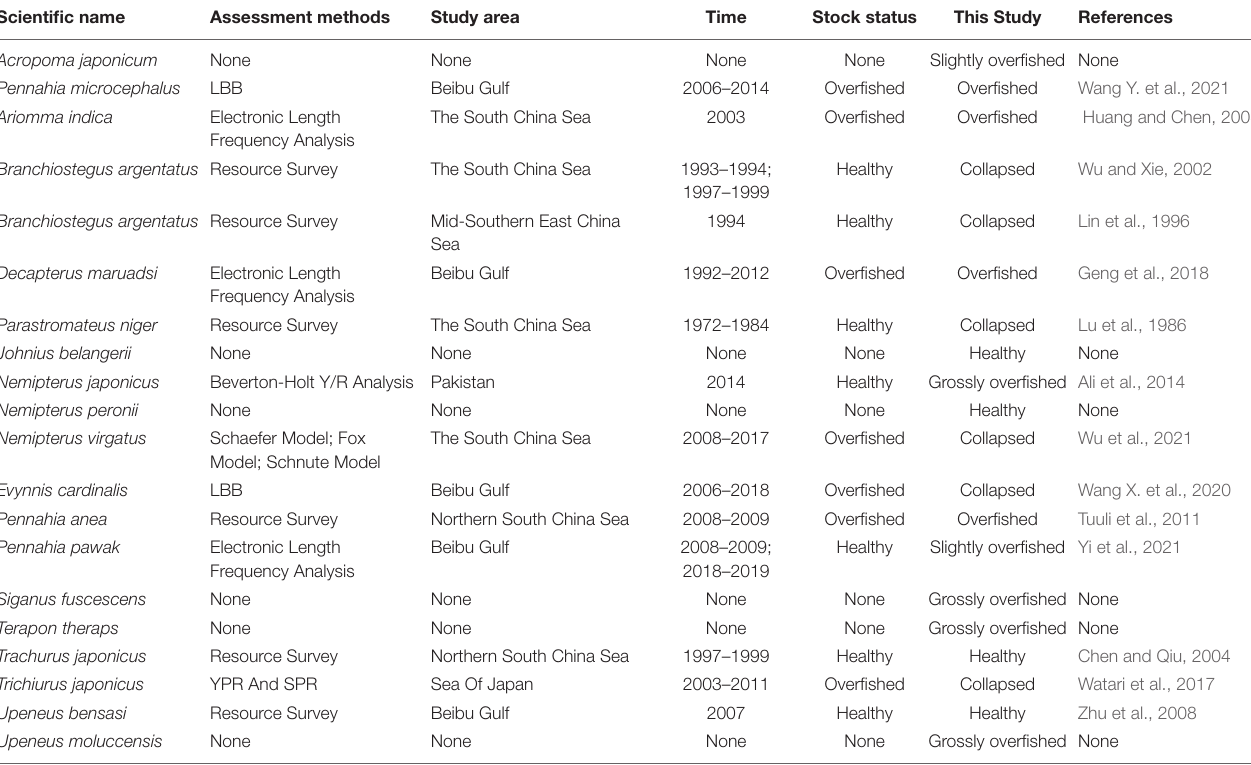
TABLE 4 | Comparison of fishery resource assessment studies for 19